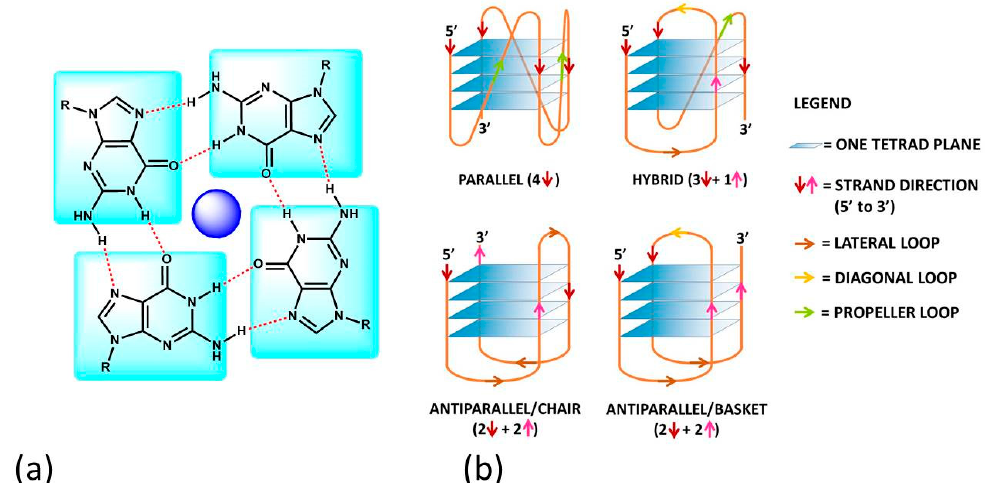
Figure 1. ( a ) The guanine-tetrad (G4) and ( b ) examples of structural conformations of G4s. In ( b ), the intramolecular type is taken into account; the same classifications hold in the intermolecular case. In ( b ), the oligonucleotide strand goes in the 5 ′ to 3 ′ direction; the vertical arrows (red or pink) indicate the direction of the part of the strand involved in G-tetrad formation, and the diagonal arrows refer to the direction of the loops. The latter can be of three types: (i) the lateral loop connects two adjacent guanines of the same G-quartet plane (brown arrow); (ii) the diagonal loop connects two opposite guanines of the same G-quartet plane (yellow arrow) and (iii) the propeller loop connects two guanines belonging to two different (upper and lower) G-quartet planes (green arrow).